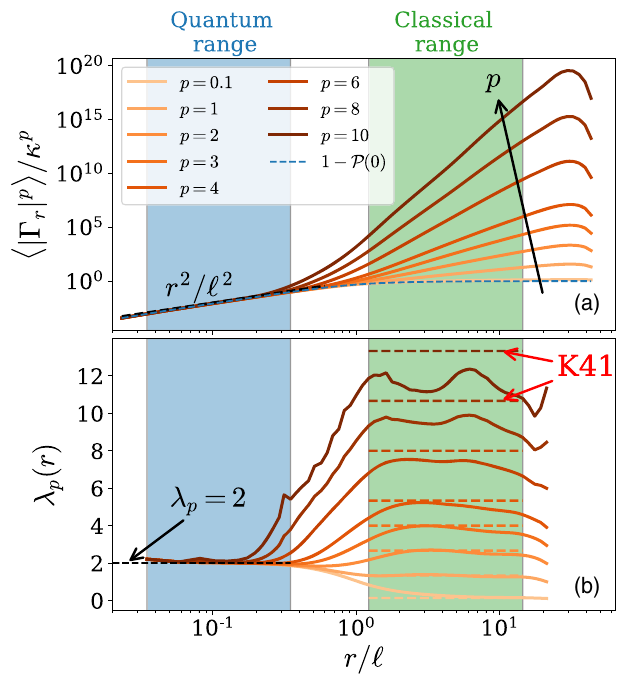
FIG. 4. (a) The p -order moments of the circulation over square loops of area A ¼ r 2 from the gGP simulation. (b) Local scaling p i(cid:3) = d ½ log r (cid:3) . Dashed horizontal r Þ ¼ d ½ log hj Γ exponents λ p ð r j 4 p= 3 . The blue lines correspond to the K41 scalings λ K 41 p ¼ Γ ≠ 0 Þ ¼ 1 − P Γ 0 Þ , which corre- dashed line shows P r ð r r ð r ¼ sponds to the p th circulation moment in the limit p → 0 þ [Eq. (6)]. The blue and green areas, respectively, illustrate the quantum and classical